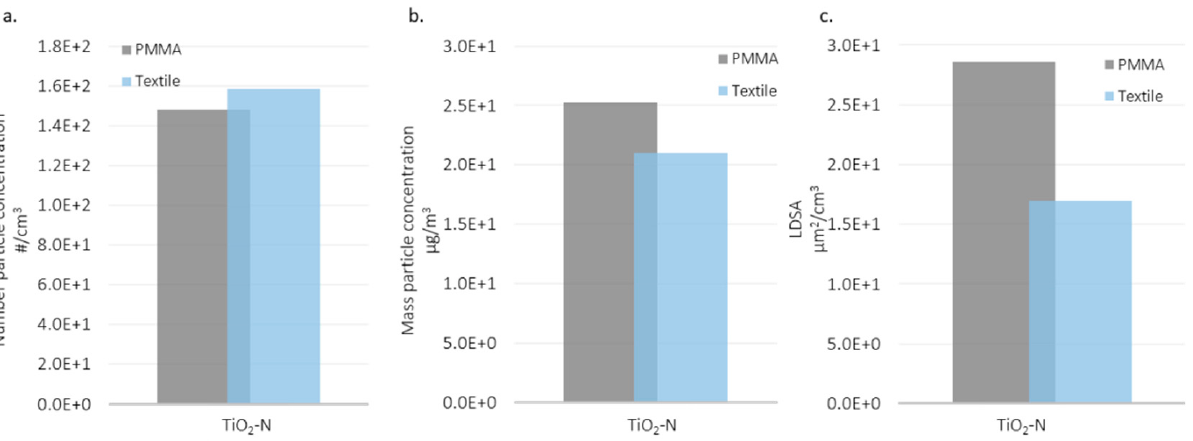
Figure 12. Histograms comparing different substrates sprayed with TiO 2 -N in the NF station: ( a )